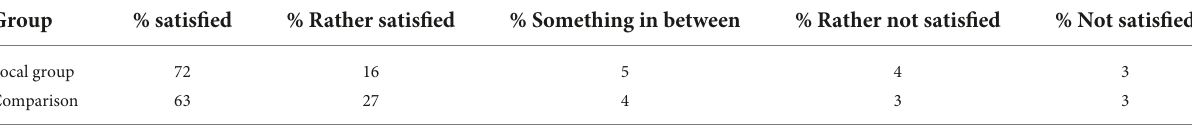
TABLE 3 Sum satisfaction with career in the focal group and comparison group.